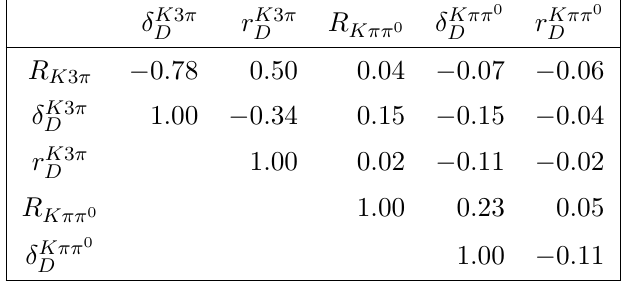
Table 19 . Correlation matrix for the hadronic parameters from the global fit to the BESIII and CLEO-c data.